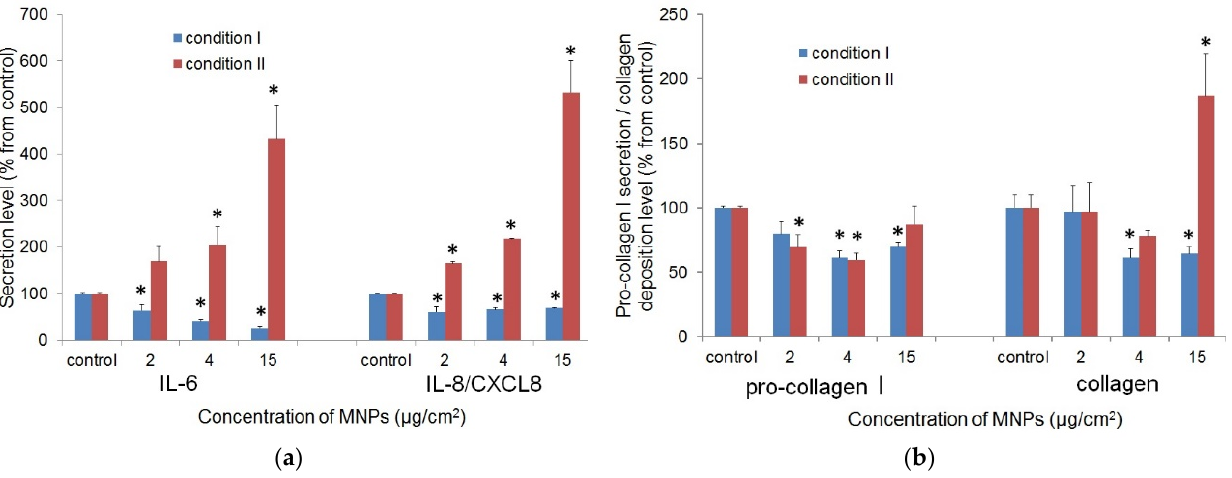
Figure 6. ( a ) Effect of MNPs on fibroblasts IL-6 and IL-8 secretion. Growth medium after fibroblasts incubation with MNPs was used for ELISA. The data presented were normalized to secretion level (pg of secreted product per 1000 cells) in control without MNPs (accepted for 100%). Values that are statistically different from control ( p < 0.05) are indicated by asterisks. ( b ) Pro-collagen I secretion and collagen deposition by fibroblasts. The quantity of pro-collagen I released and collagen deposited (ng per 1000 cells) in MNP-free control was accepted for 100%. Values that are statistically different from control ( p < 0.05) are indicated by